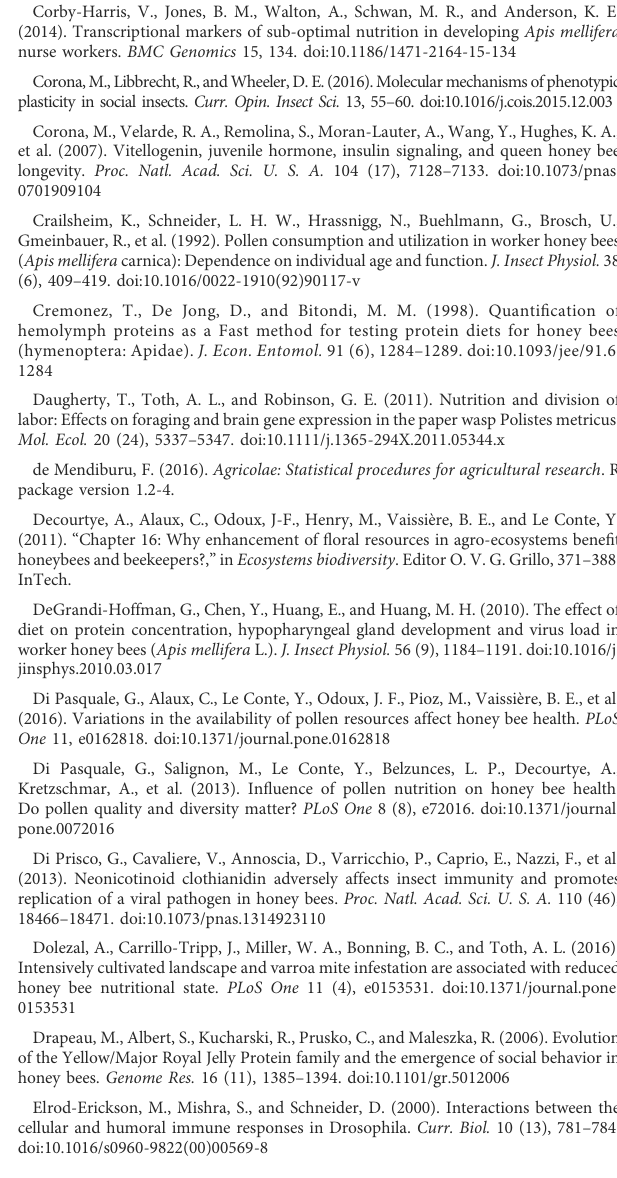
young (Y) vs. old (O), pollen-unrestricted (U) vs. pollen restricted (R) (e.g., pollen unrestricted nurses = Y-U-N). Expression ratios were obtained dividing the ARVs from each pair of variables and used for calculation of differentially ampli fi ed targets. For each pair comparison, targets were sortedoutwiththehigherARVsvaluesandratiosonthetop.Singlevariable: A2 (behavior). B1 (age), B2 (nutrition). Double variable: C (age-behavior), D (behavior-nutrition), E (age-nutrition) F (age-behavior). Triple variable: Nutritional comparisons (G, H), Age comparisons (I, J), behavioral comparisons (K, L). SUPPLEMENTARY TABLE 4 Correlationsamonggenesandviruses.Correlationsintheexpressionlevelof the different genes and viruses were analyzed by the Spearman Rank Correlation Test. Positive and negative correlations are indicated in green and red case, respectively. Signi fi cant p - values are indicated in bold